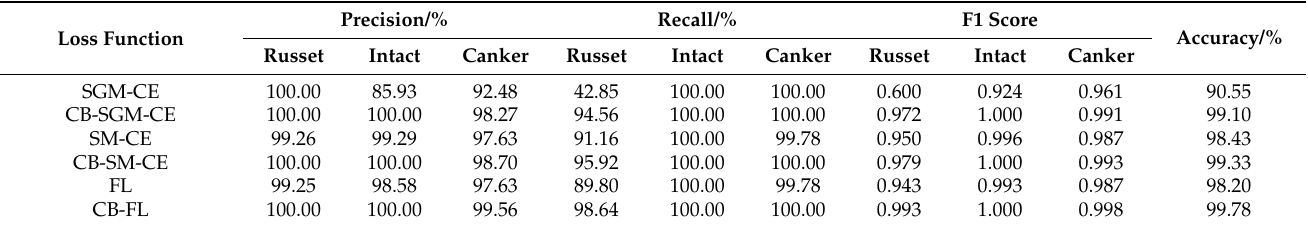
Table 2. Results of testing using different loss